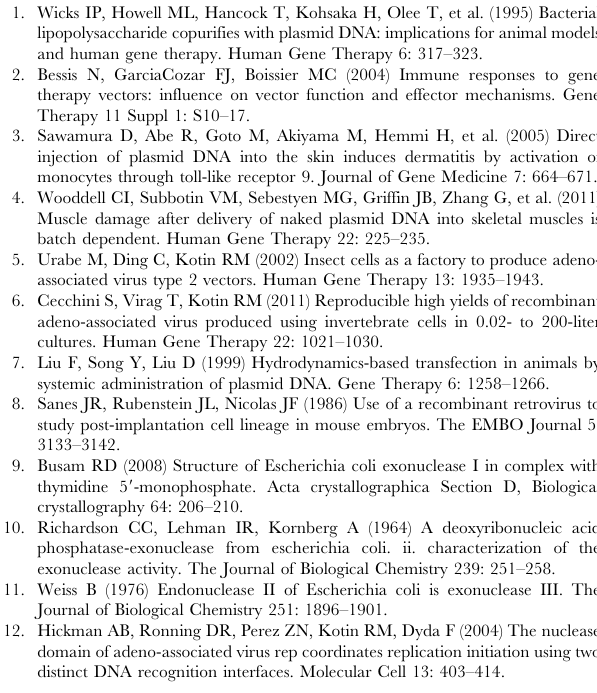
Figure S1 Restriction endonuclease digestion products